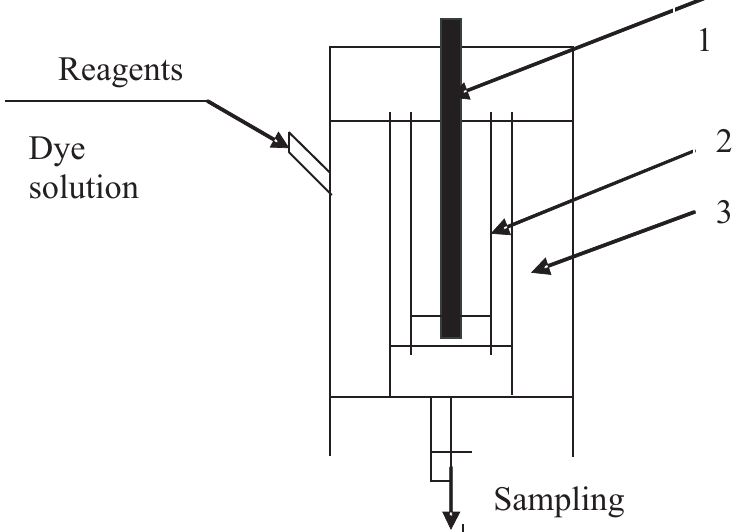
Fig. 1 Schematic drawing of the photoreactor: 1, UV lamp; 2, quartz cooling jacket; 3, reaction